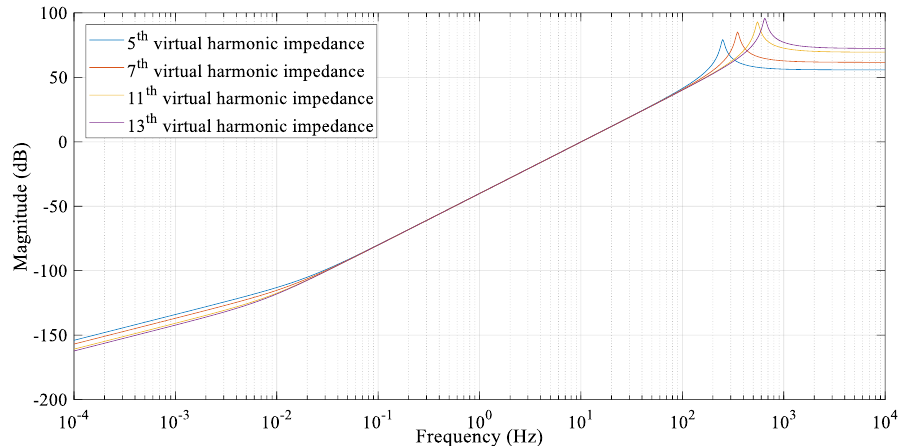
Figure 7. Frequency response of virtual harmonic impedance.